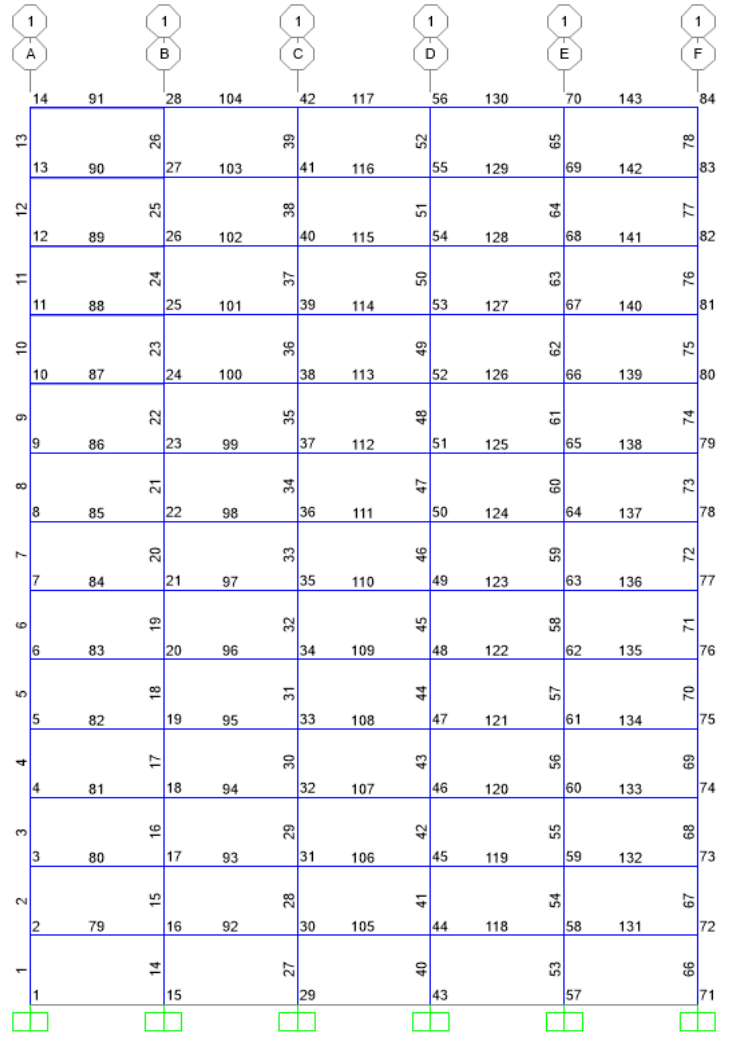
( c ) Figure 6. Column removal scenario in ( a ) story one, ( b ) story six, and ( c ) story thirteen.